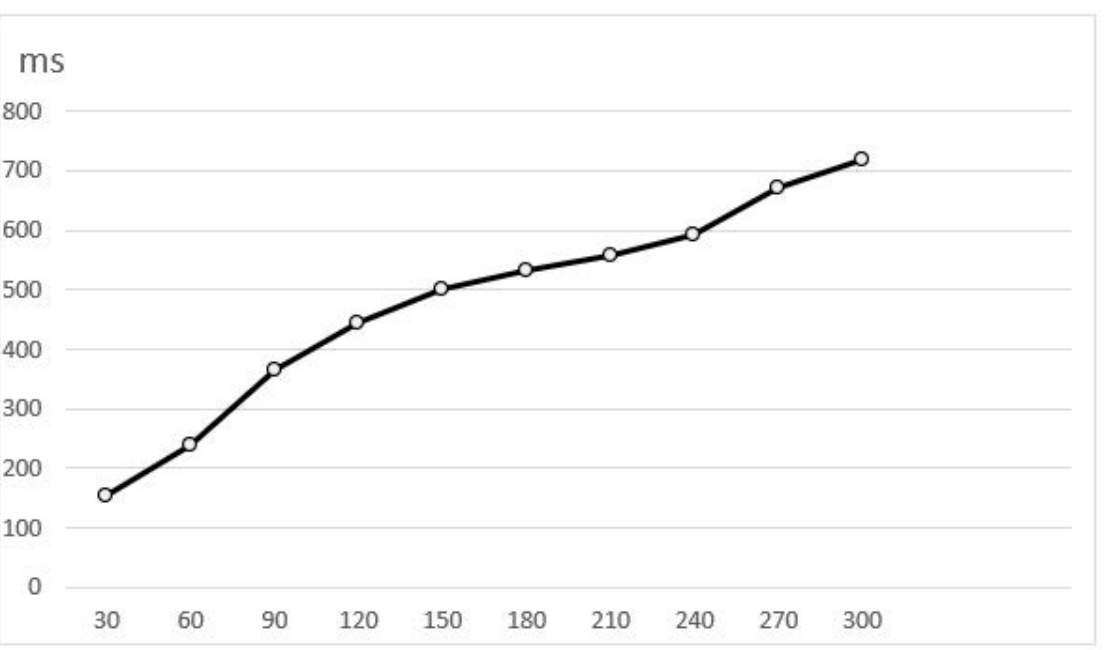
Figure 10. Failure of authentication request within 1 s.